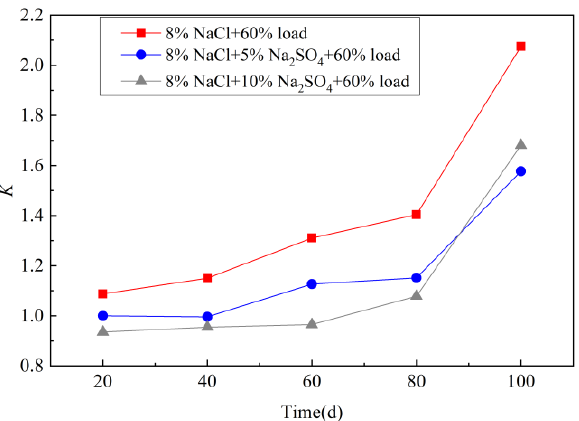
Figure 7. Regular time varying of the effect coefficient K immersed in different sodium sulfate and sodium chloride coupling of the cyclic loading condition.